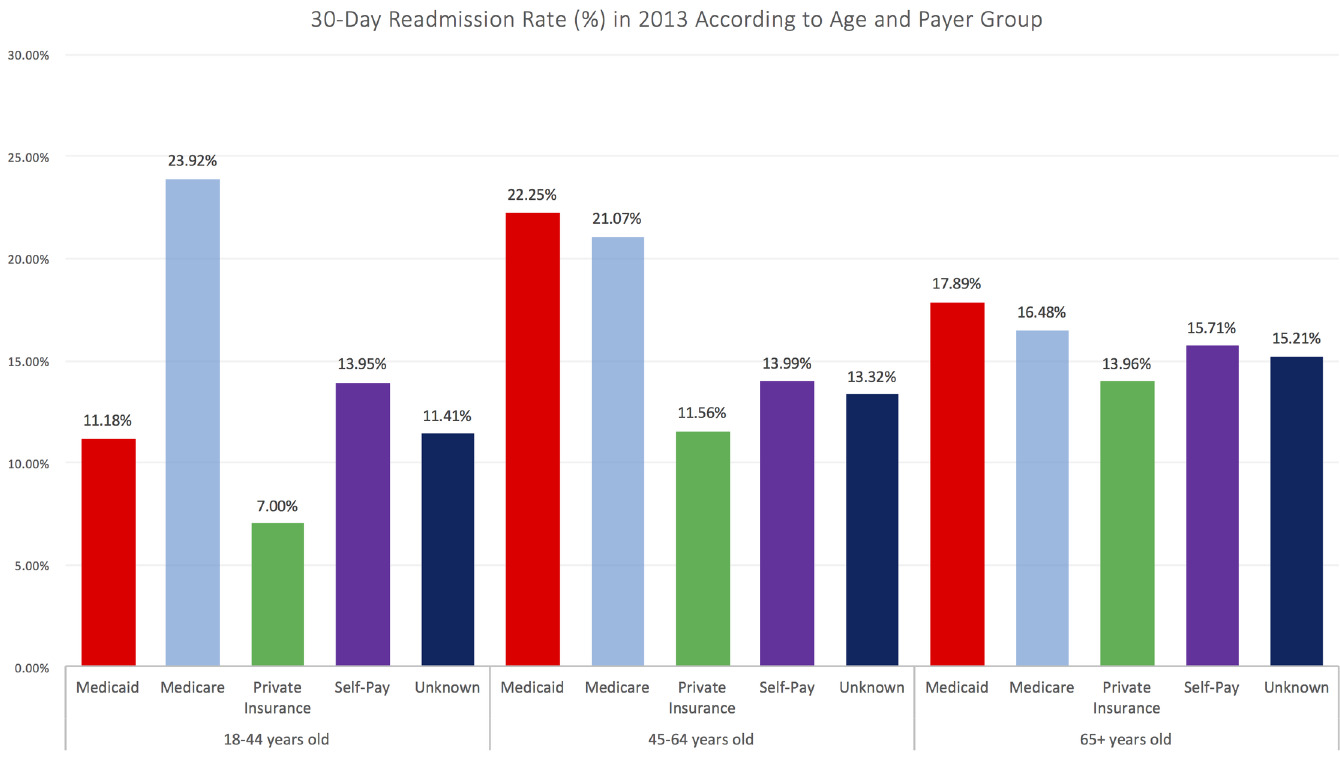
Fig 1. Readmission rates stratified by age and insurance category * . * All rates are expressedas percentages by age category. https://doi.org/10.1371/journal.pone.0180767.g001 ( Table C in S1 File ) Among younger adults ages 18–44 years old, psychiatric disease, compli-